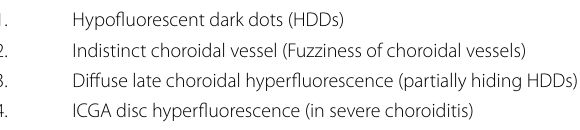
Table 1 ICG angiographic signs in stromal choroiditis